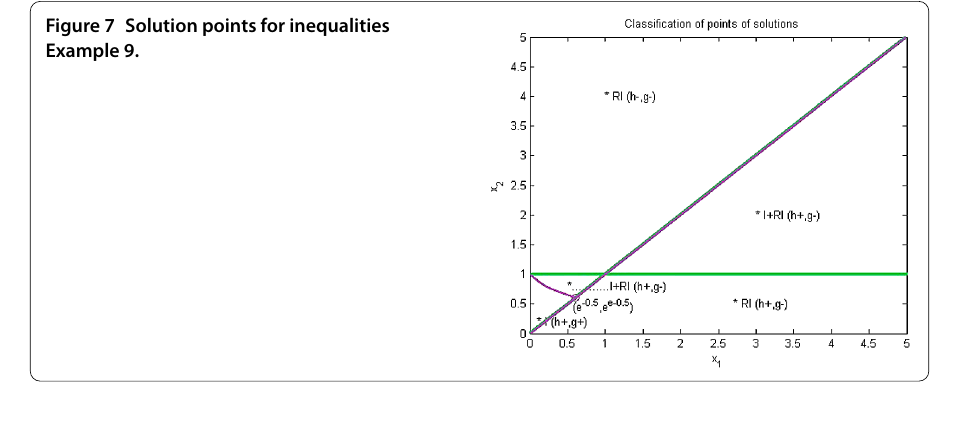
Figure 8 Solution points for inequalities Example